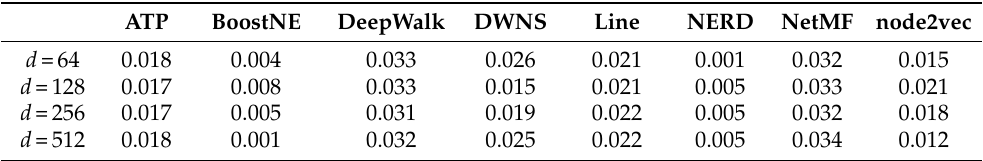
Table A4. Precision values of all embedding methods with the TREC dataset and different values of d